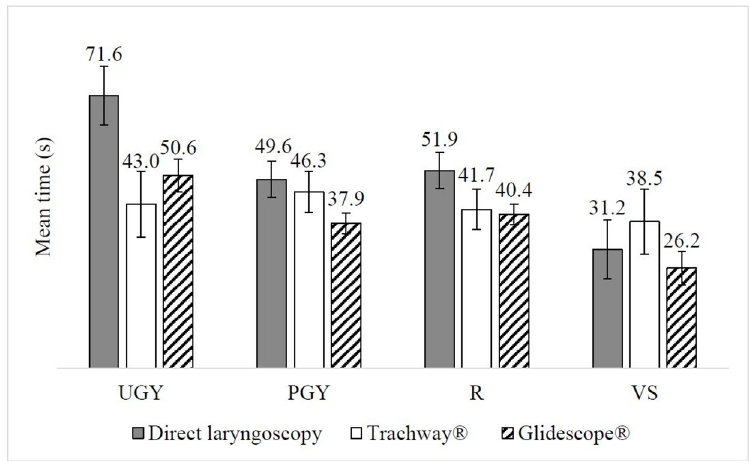
Fig 2. Mean time to intubation(s) across UGY, PGY, R and VS using different intubation devices. Error bars represent ± 1 SE.